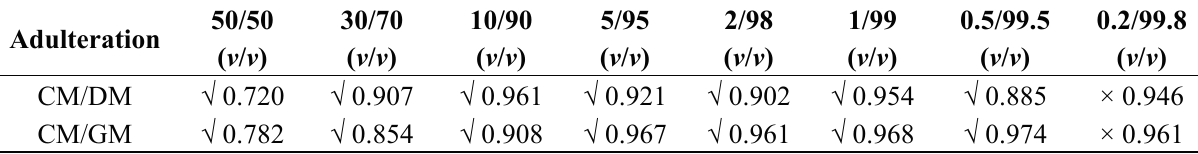
Table 1. The identification ability (expressed by the symbol  = Yes, × = No) of different percentages of DM and GM adulteration obtained by our combined analytical and statistical approach; the correspondent correlation coefficients are also